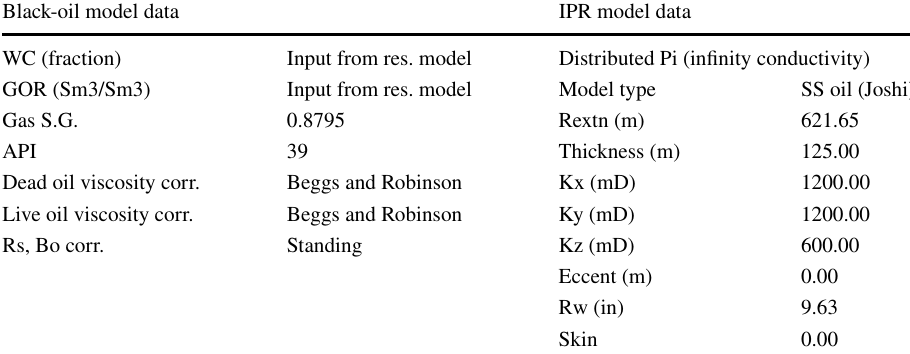
Table 15 Black-oil and IPR model data used in network